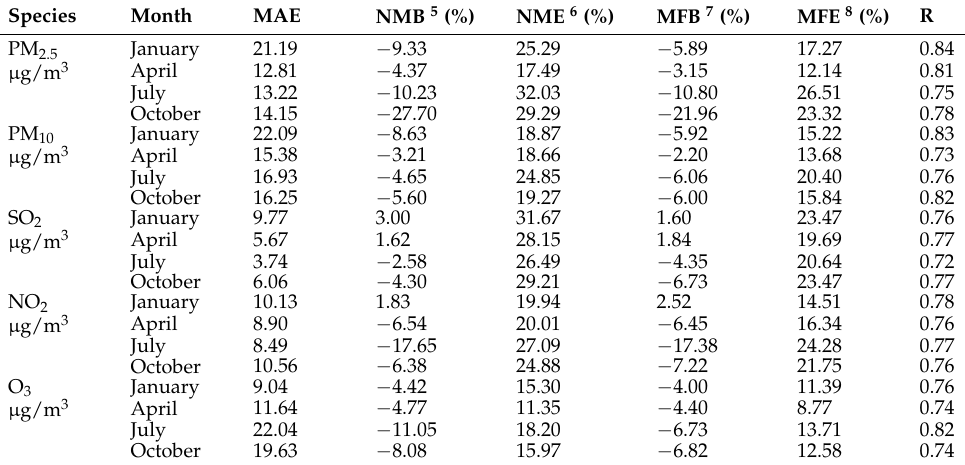
Table 2. Performance statistics for PM 2.5 , PM 10 , SO 2 , NO 2 , O 3 concentrations at 171 sites within the study